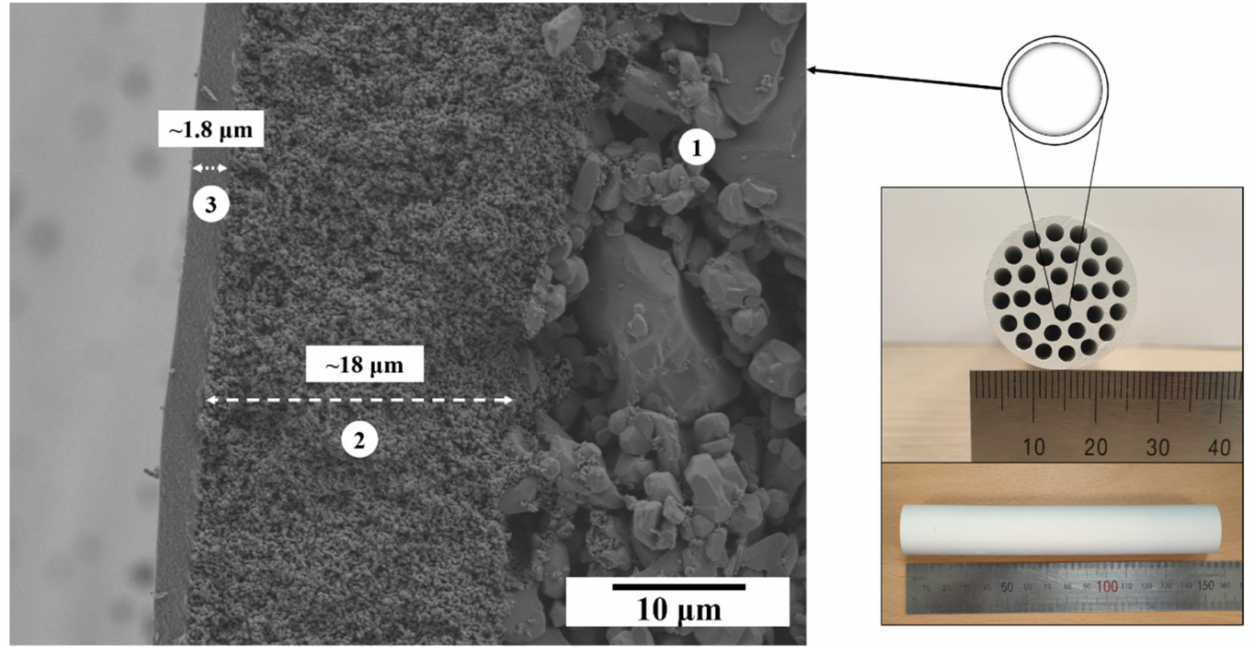
Figure 10. Cross-section of the asymmetric multichannel cylindrical tube-type substrate: (1) macrop- orous support; (2) intermediate microfiltration layer; and (3) γ -Al 2 O 3 tight ultrafiltration (UF)